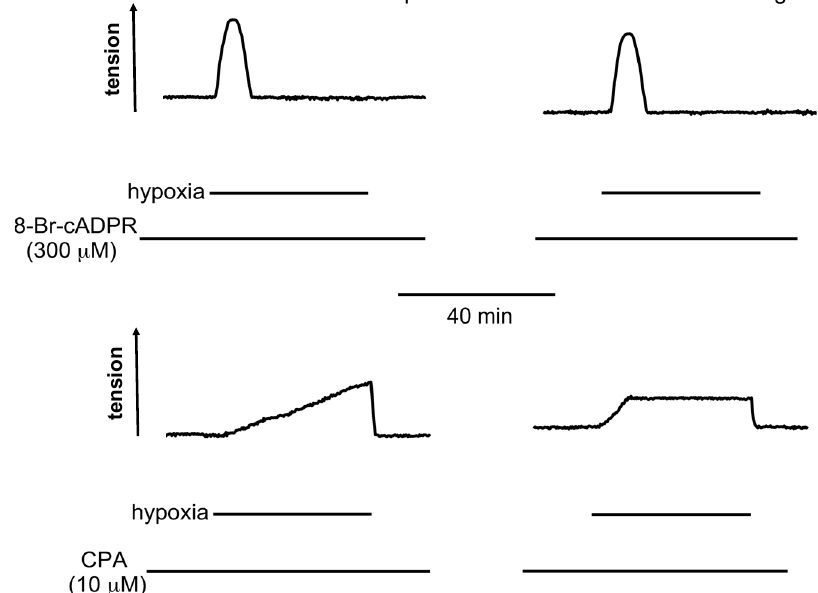
Figure 4. Example records show that pre-incubation of pulmonary artery rings with 8-bromo-cADPR, a cADPR antagonist, blocked phase 2, but not phase 1, of HPV ( upper panels ). By contrast, depletion of sarcoplasmic reticulum calcium stores with cyclopiazonic acid (CPA) blocked phase 1, but not phase 2, of HPV ( lower panels ).